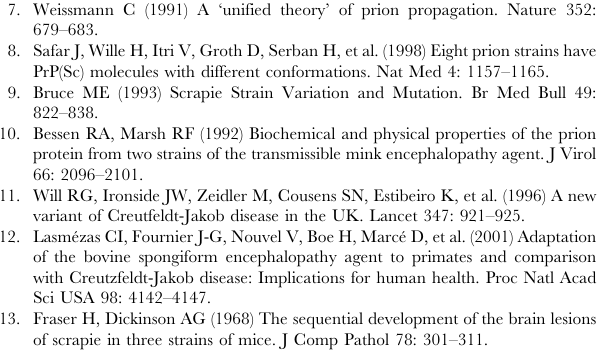
Figure S2 PrPC in spleens of C57BL/6 and Tga20 mice. PrP was stained using the monoclonal antibody D18. General procedures were similar to those described for the processing of brain tissue. The differences were that tissue pretreatment consisted only of exposure to guanidinium thiocyanate without PK treatment, and D18 anti-PrP antibody was used at 5 m g/ml for 2 h followed by washes with PBS and incubation with secondary anti-human IgG linked to HRP (Southern Biotech) at 1 m g/ml for 2 h. A, C : PrPC in the spleens of C57BL/6 is seen in the germinal centers of follicles. B, D : PrPC is not detectable in the follicles of Tga20 mouse spleens, but can be seen in the interfollicular zones (red pulp). Bars represent 100 m m (upper panels) or 20 m m (lower panels). Figure S3 Quantification of TL- and PK-resistant PrP. UVP quantification data of PrP immunoreactive bands, expressed in arbitrary pixel units, were plotted against the sample concentra- tion. Regression curves show good signal linearity over the dilution series. The ratio of PK- or TL-resistant PrP in C57BL/6 versus Tga20 mice is calculated from the ratio of the slopes of the corresponding regression